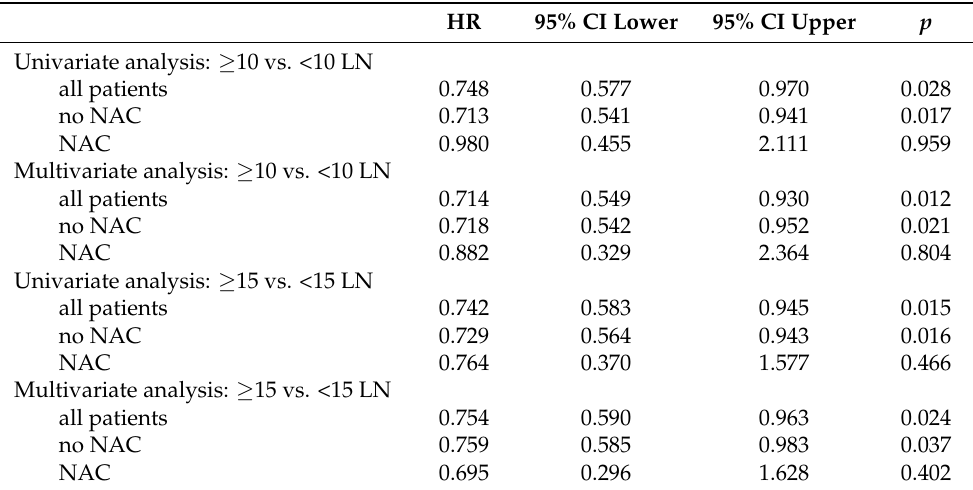
Table 2. Effect of adequate lymphadenectomy in univariate and multivariate Cox regression analyses for prediction of overall survival, stratified according to the receipt of neoadjuvant chemotherapy.